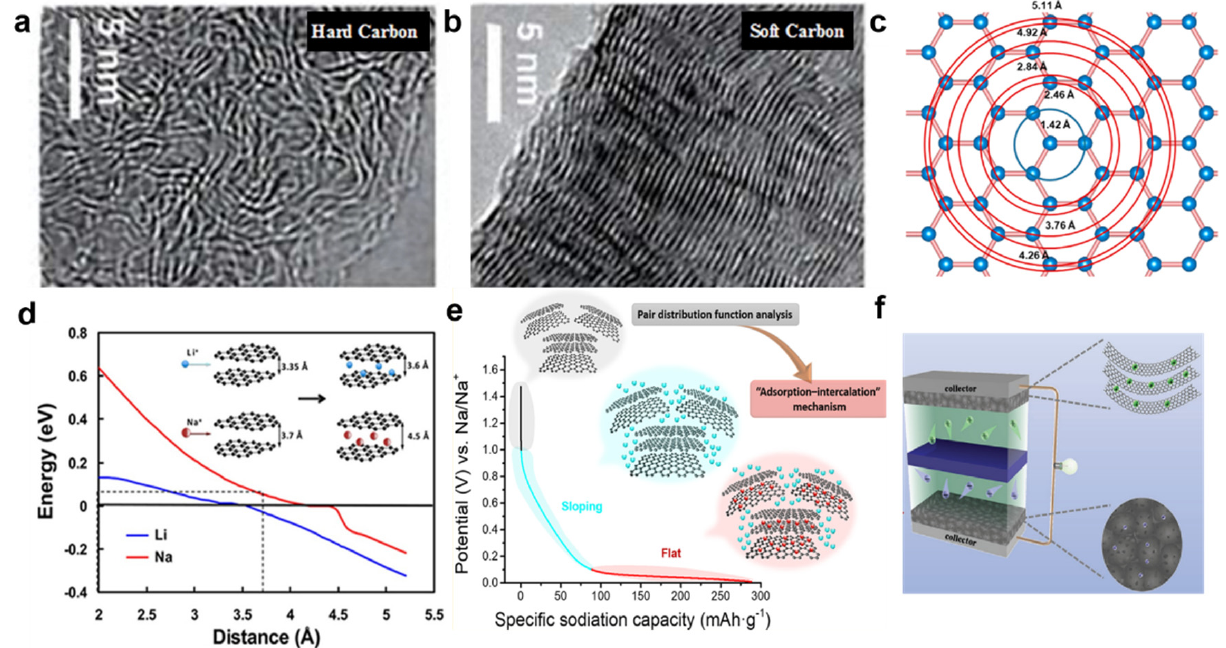
Figure 2. TEM image of hard carbon ( a ) and soft carbon ( b ). Reprinted with permission from Ref. [67]. Copyright 2017 American Chemical Society. ( c ) Schematic of the atomic structure of graphene and near-neighbor interatomic distances. Reprinted with permission from Ref. [68]. Copyright 2019 American Chemical Society. ( d ) Theoretical energy cost for Na (red curve) and Li (blue curve) ions insertion into carbon as a function of carbon interlayer distance. Reprinted with permission from Ref. [69]. Copyright 2012 American Chemical Society. ( e ) Schematic illustration of the mechanism for Na storage in hard carbon. Reprinted with permission from Ref. [68]. Copyright 2019 American Chemical Society. ( f ) Schematic of SIBs. Reprinted with permission from Ref. [70]. Copyright 2017 Wiley-VCH.